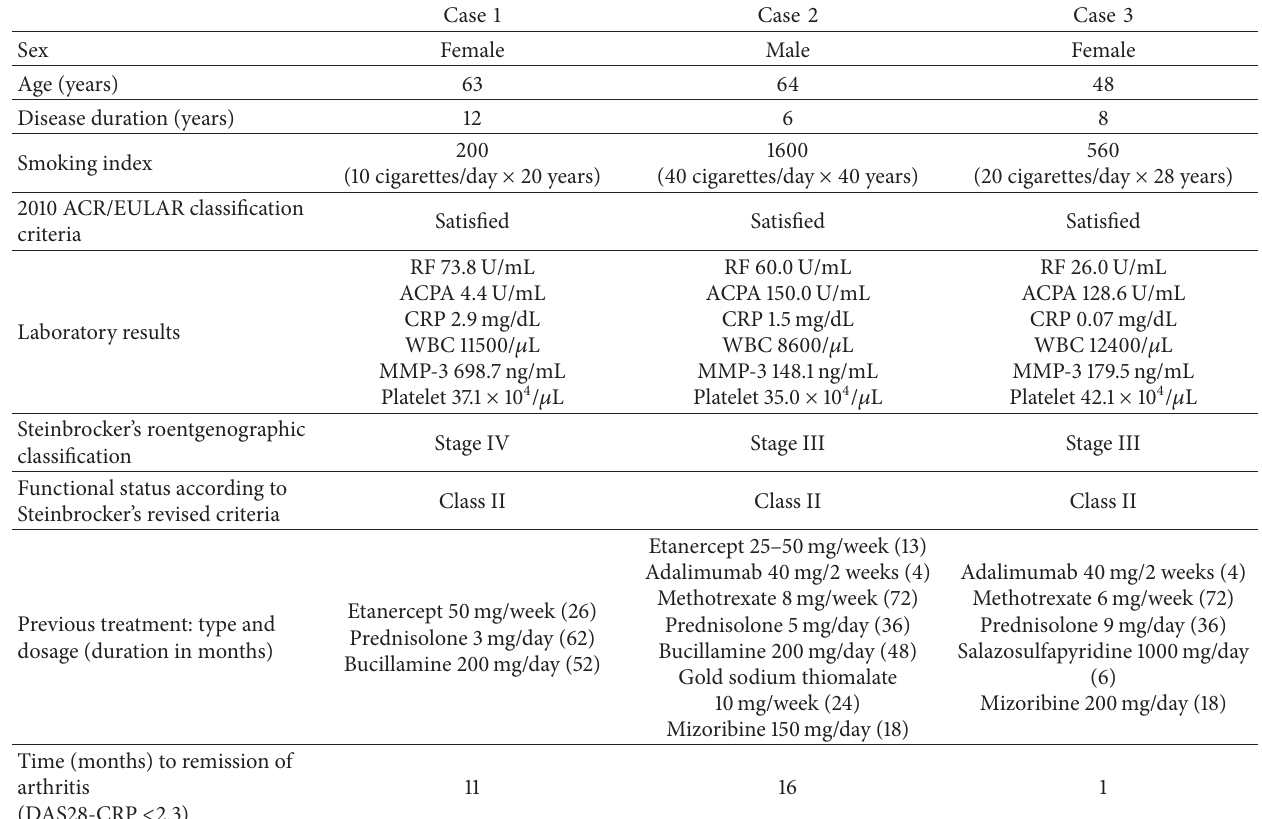
Table 1: Characteristics of